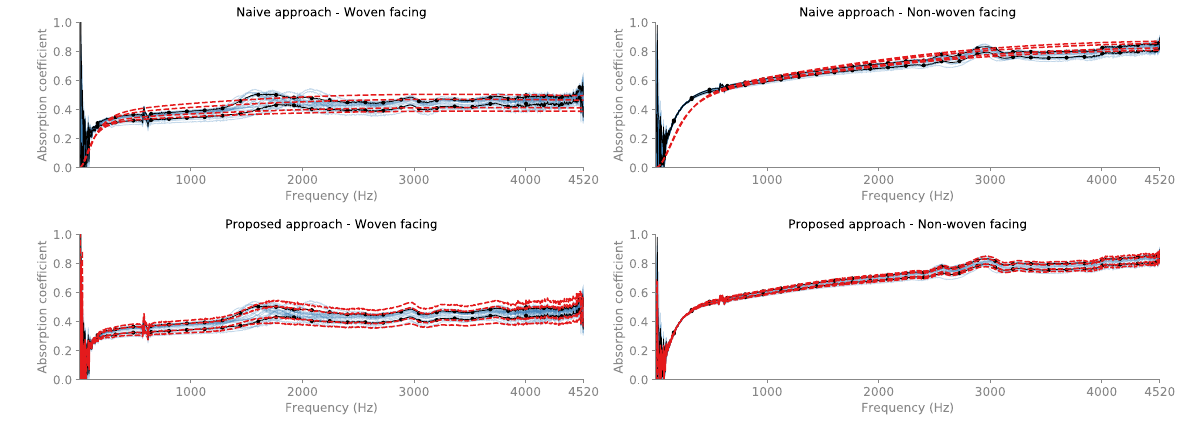
Figure 13. Case of a glass wool backing. Comparison of envelopes (in red) annotated on the mean response as proposed in Section 2.3 (bottom) and envelopes generated using the JCA characterisation of the backing and the fi lm (top). For a woven fi lm (left) and a non- woven (right). The blue light traces are sample responses and the black curve with bullets (cid:7) is the standard deviation